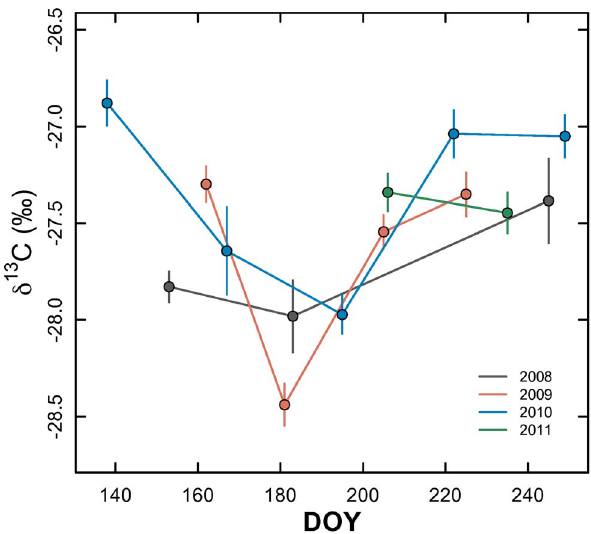
Figure 2. Changes in mean leaf d 13 C ( % ) ( ± 1SE) by day of year across the growing season from 2008–2011.